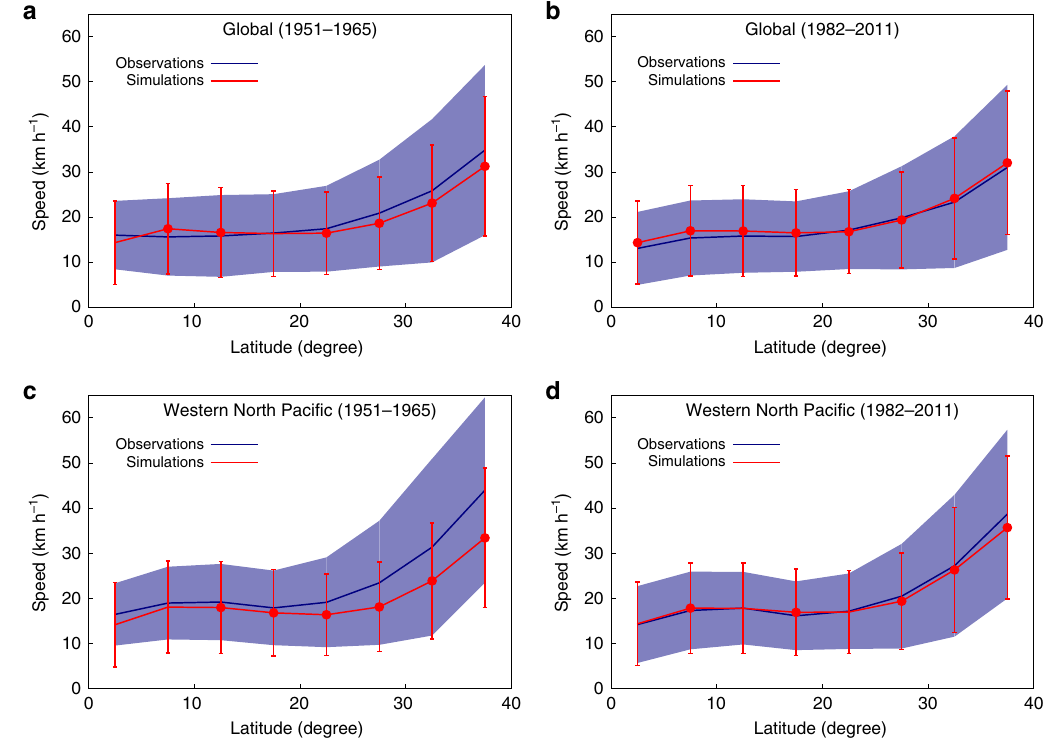
Fig. 2 Global and Western North Paci fi c basin mean tropical cyclone translation speed against latitudes from the observations and simulations a – d The range of the latitude is 0 – 40° with 5° interval. Navy blue (red) line is for the observations (simulations). Vertical shading (bars) indicates 1 standard deviation in the bins for the observations (simulations). The latitudinal distribution is shown for the global data over the pre-satellite era ( a ) and over the post-geostationary satellite era ( b ), and for the Western North Paci fi c basin data over the pre-satellite era ( c ) and over the post-geostationary satellite era ( d ). Red dots mean the difference between the observations and simulations is statistically signi fi cant at a 99% level ( p < 0.01, two-tailed Student ’ s t